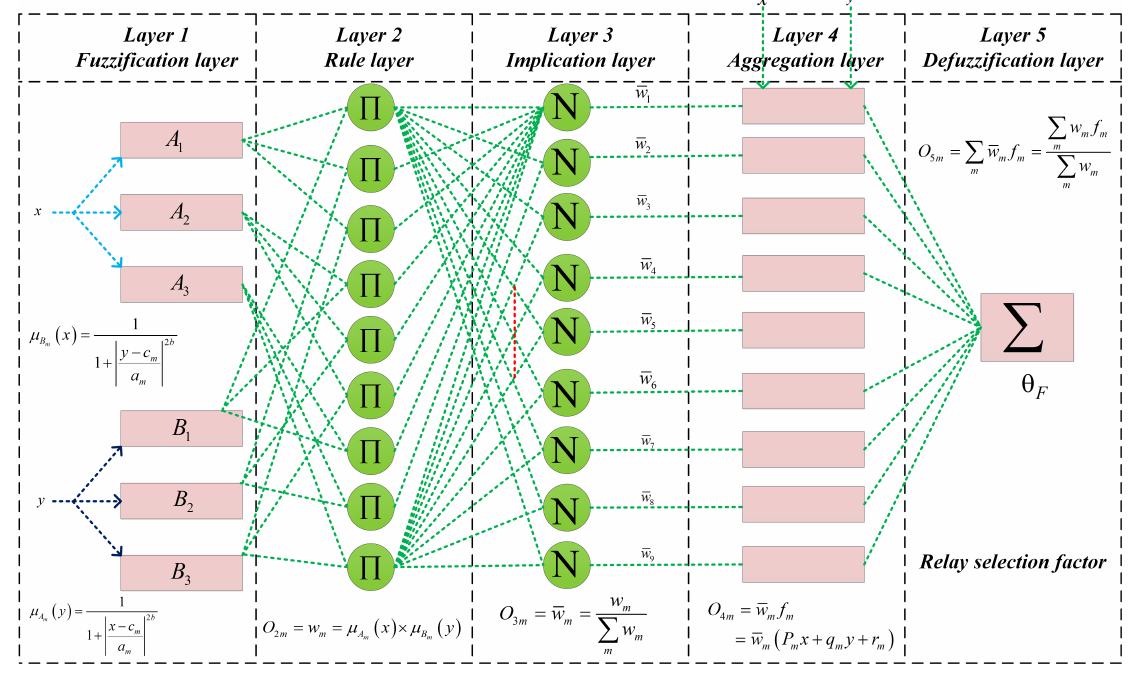
Figure 3. Proposed ANFIS architecture for relay